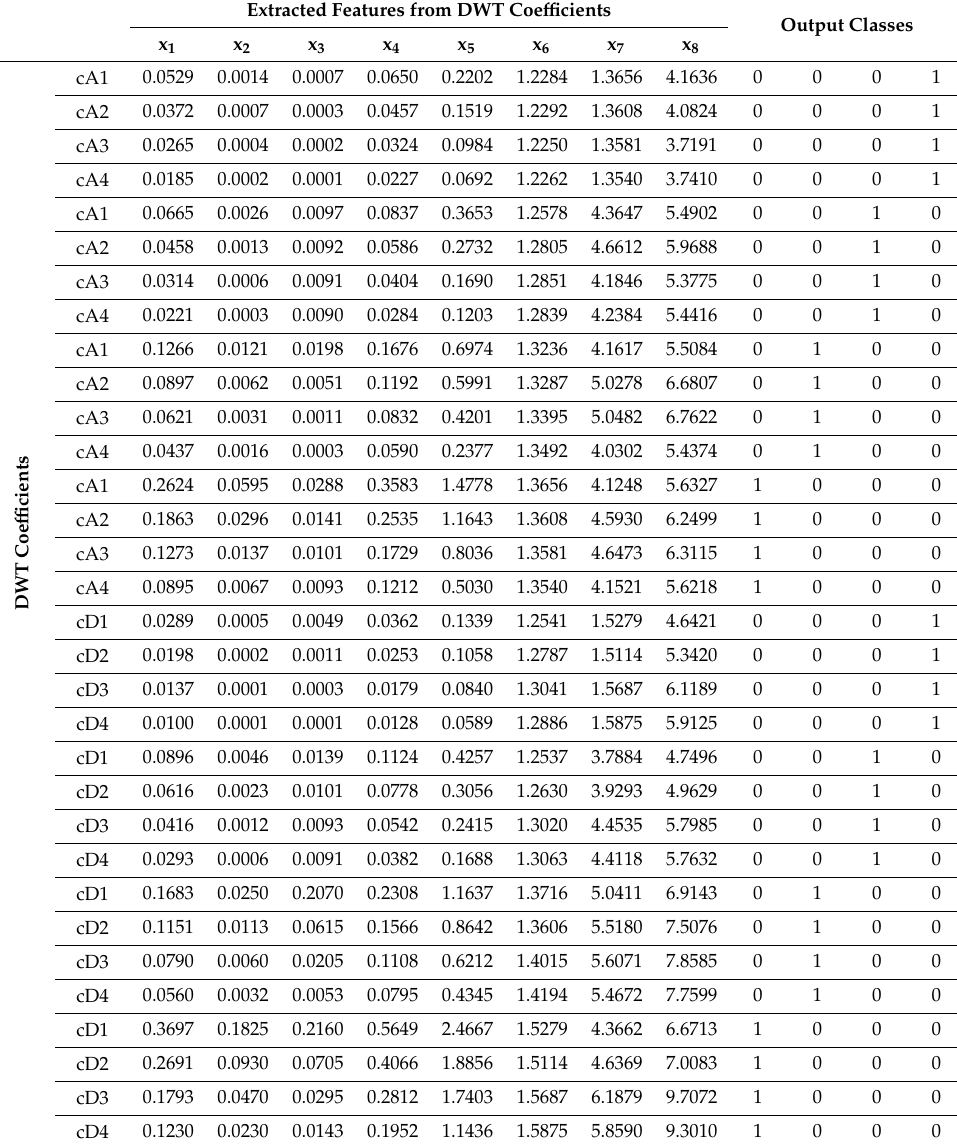
Table 3. List of statistical features and the output classes for di ff erent bearing conditions. Extracted Features from DWT Coe ffi